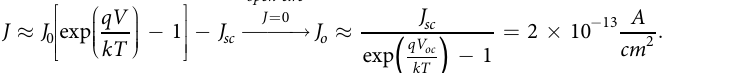
Figure 3. Schematic band diagram of a heterojunction solar cell with a hybrid PEDOT:PSS/c-Si front junction and a c-Si/a-Si(i)/a-Si(n + ) back junction in the dark. The built-in voltage ψ Conduction and valence band positions are taken from literature. The valence and conduction band offsets are marked